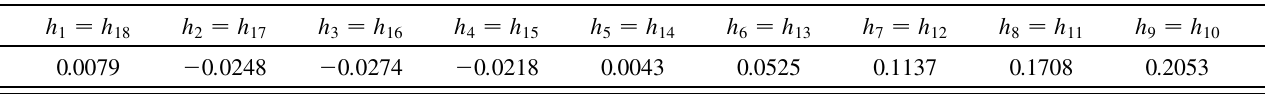
TABLE V. Coefficients of an 8 MHz FIR low pass with a sample frequency of 54 MHz and an attenuation of (cid:4) 28 dB